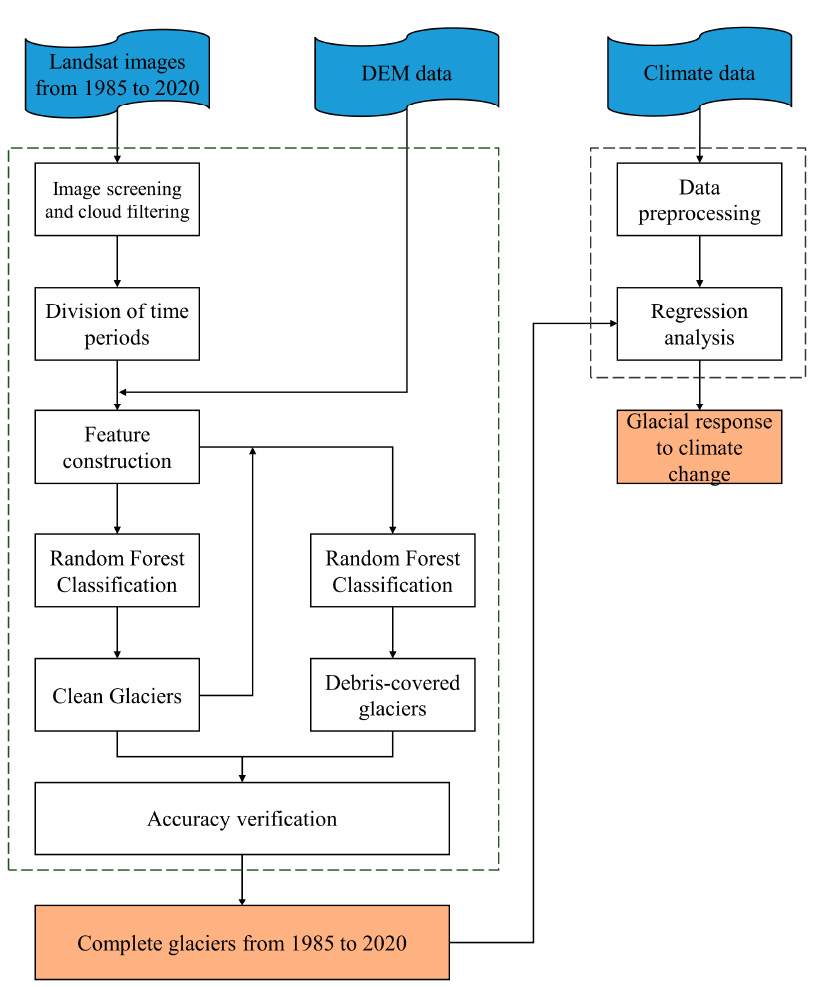
Figure 2. Flowchart of the